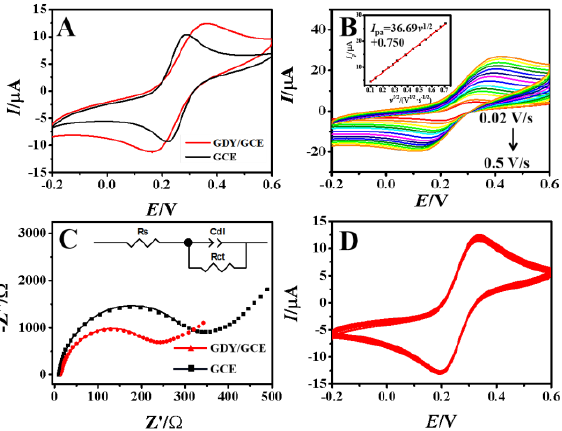
Figure 4. CV curves of ( A ) GCE and GDY/GCE at the scan rate of 0.1 V/s, ( B ) GDY/GCE at different scan rate (inset the linear relationship of I pa versus square root of scan rate) in 1.0 mM [Fe(CN) 6 ] 3 − /4 − solution containing 1.0 M KCl, ( C ) Nyquist plots of GCE and GDY/GCE in 5.0 mM [Fe(CN) 6 ] 3 − /4 − solution containing 0.1 M KCl in the frequency range from 10 kHz to 0.1 Hz with the amplitude of 0.005 V and the potential of 0.3 V. Inset shows the Randle equivalent circuit that consists of the electrolyte resistance (R s ), charge transfer resistance (R ct ) and double layer capacitance (C dl ), ( D ) Multi − scan CV curves of GDY/GCE in 1.0 mM [Fe(CN) 6 ] 3 − /4 − containing 1.0 M KCl solution at the scan rate of 0.1